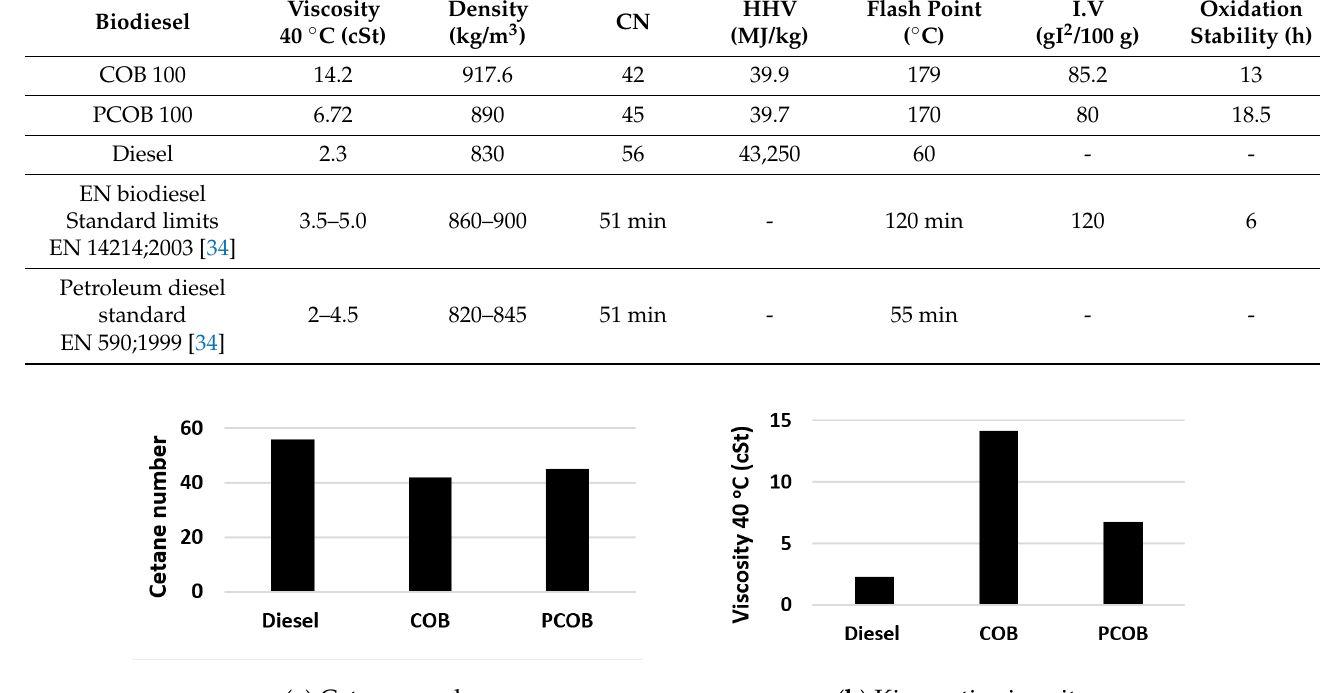
Table 5. Comparison of the biodiesel fuel properties with and without pyrolysis process. Biodiesel